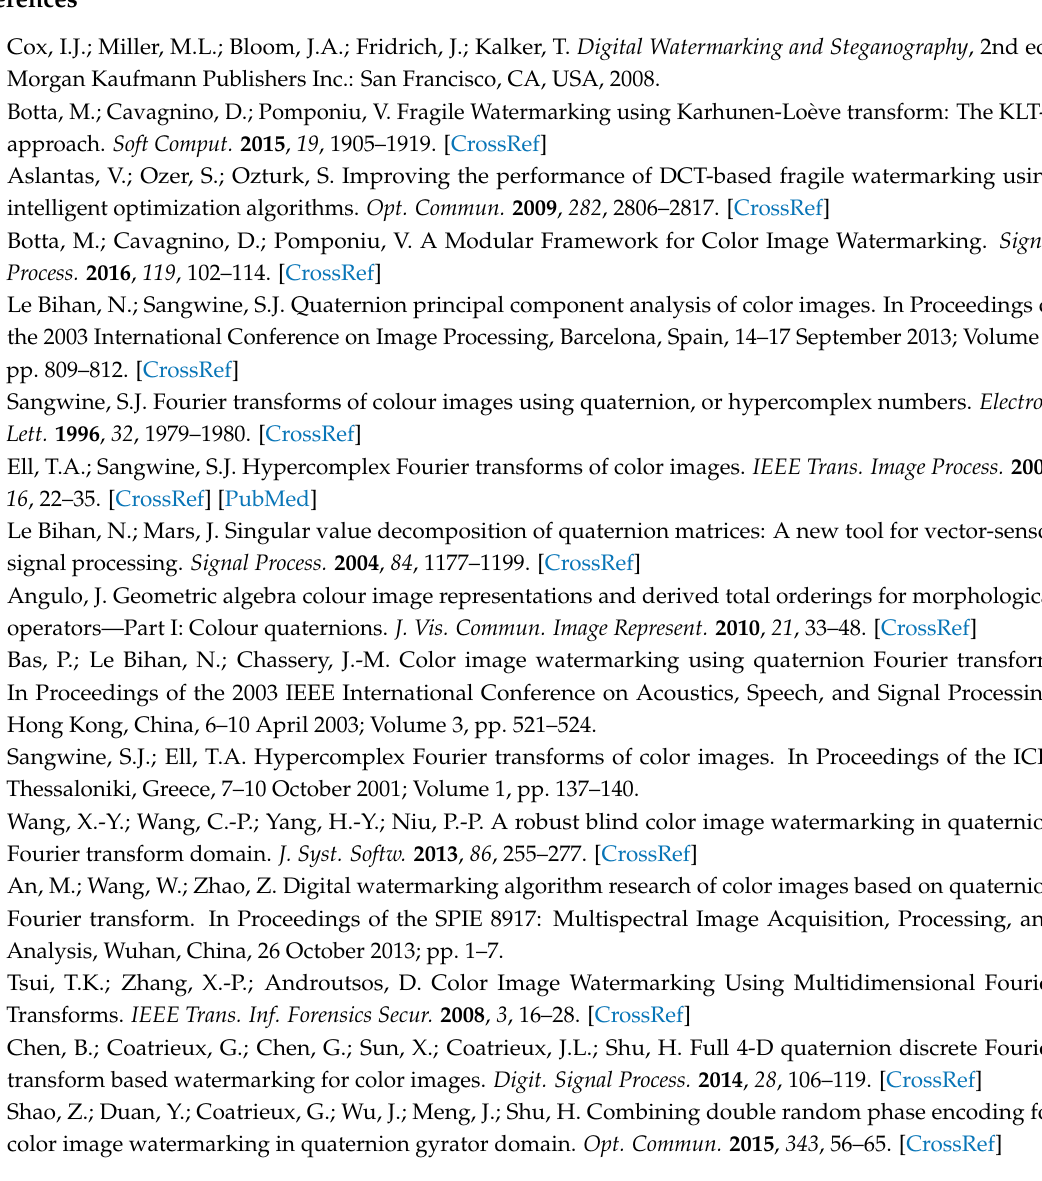
Figure A3. Verified image, with (nineteen) tampered blocks evidenced as crossed areas.